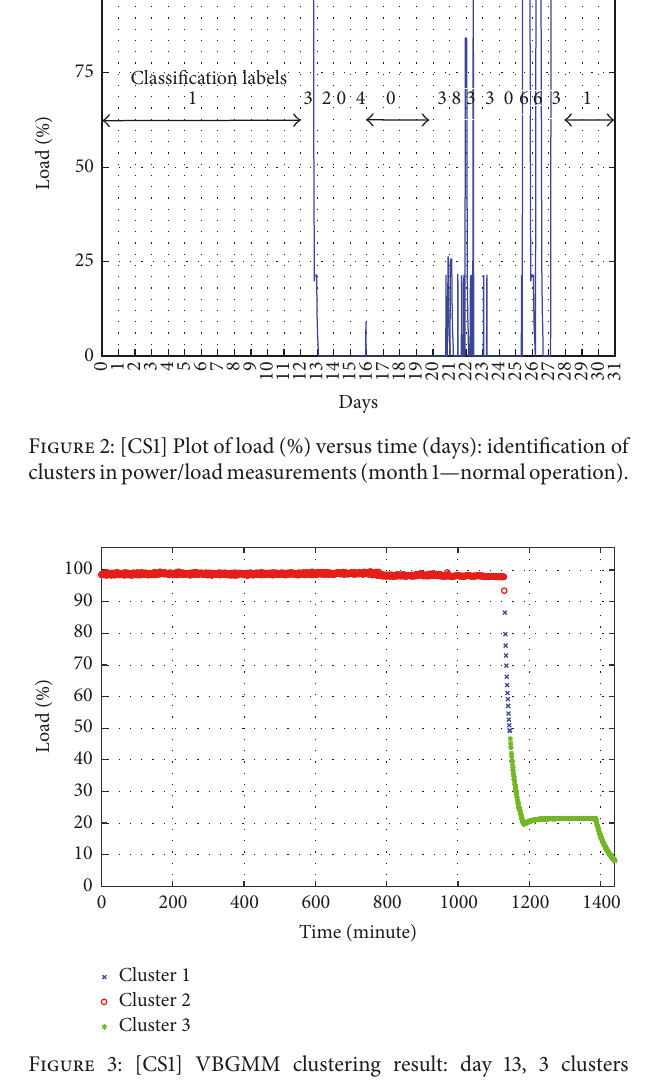
Figure 3: [CS1] VBGMM clustering result: day 13, 3 clusters identified, that is, non-steady-state data incorporating load changes.